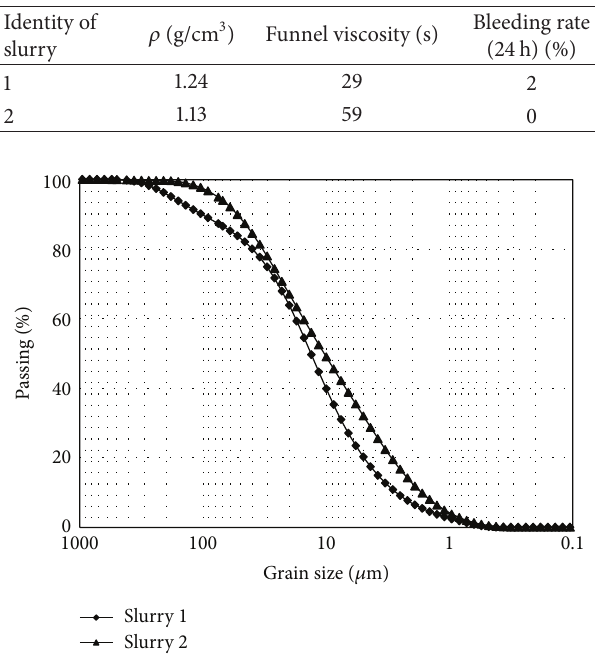
Figure 2: Grain size distribution curves for test